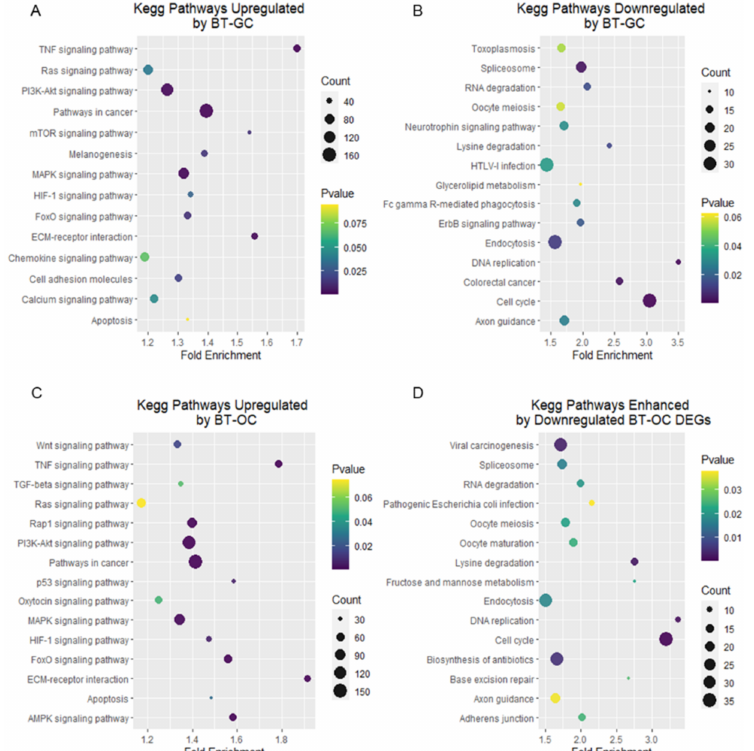
Figure 3. Significantly enriched KEGG pathways of BT-GC and BT-OC DEGs. ( A ) Bubble plot of the most significantly enriched KEGG pathways by the upregulated DEGs of BT-GC. ( B ) The most significantly enriched KEGG pathways by the downregulated DEGs of BT-GC. ( C ) Bubble plot of the most significantly enriched KEGG pathways by the upregulated DEGs of BT-OC. ( D ) The most significantly enriched KEGG pathways by the downregulated DEGs of BT-OC. The x-axis displays the fold enrichment, the y-axis represents the enriched pathways, the size of the bubbles pertains to the count/number of genes within the pathway, and the colors refer to the significance ( p -value ≤ 0.05). The analysis was performed using the Database for Annotation, Visualization, and Integrated Discovery ver.6.8 (DAVID). Visualization was conducted using R